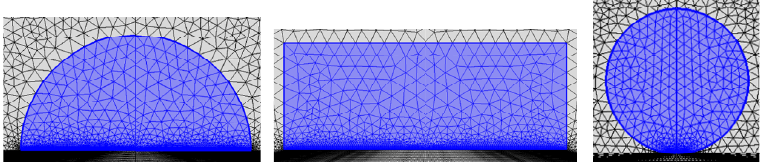
Figure 16. The OBSs with various shapes.